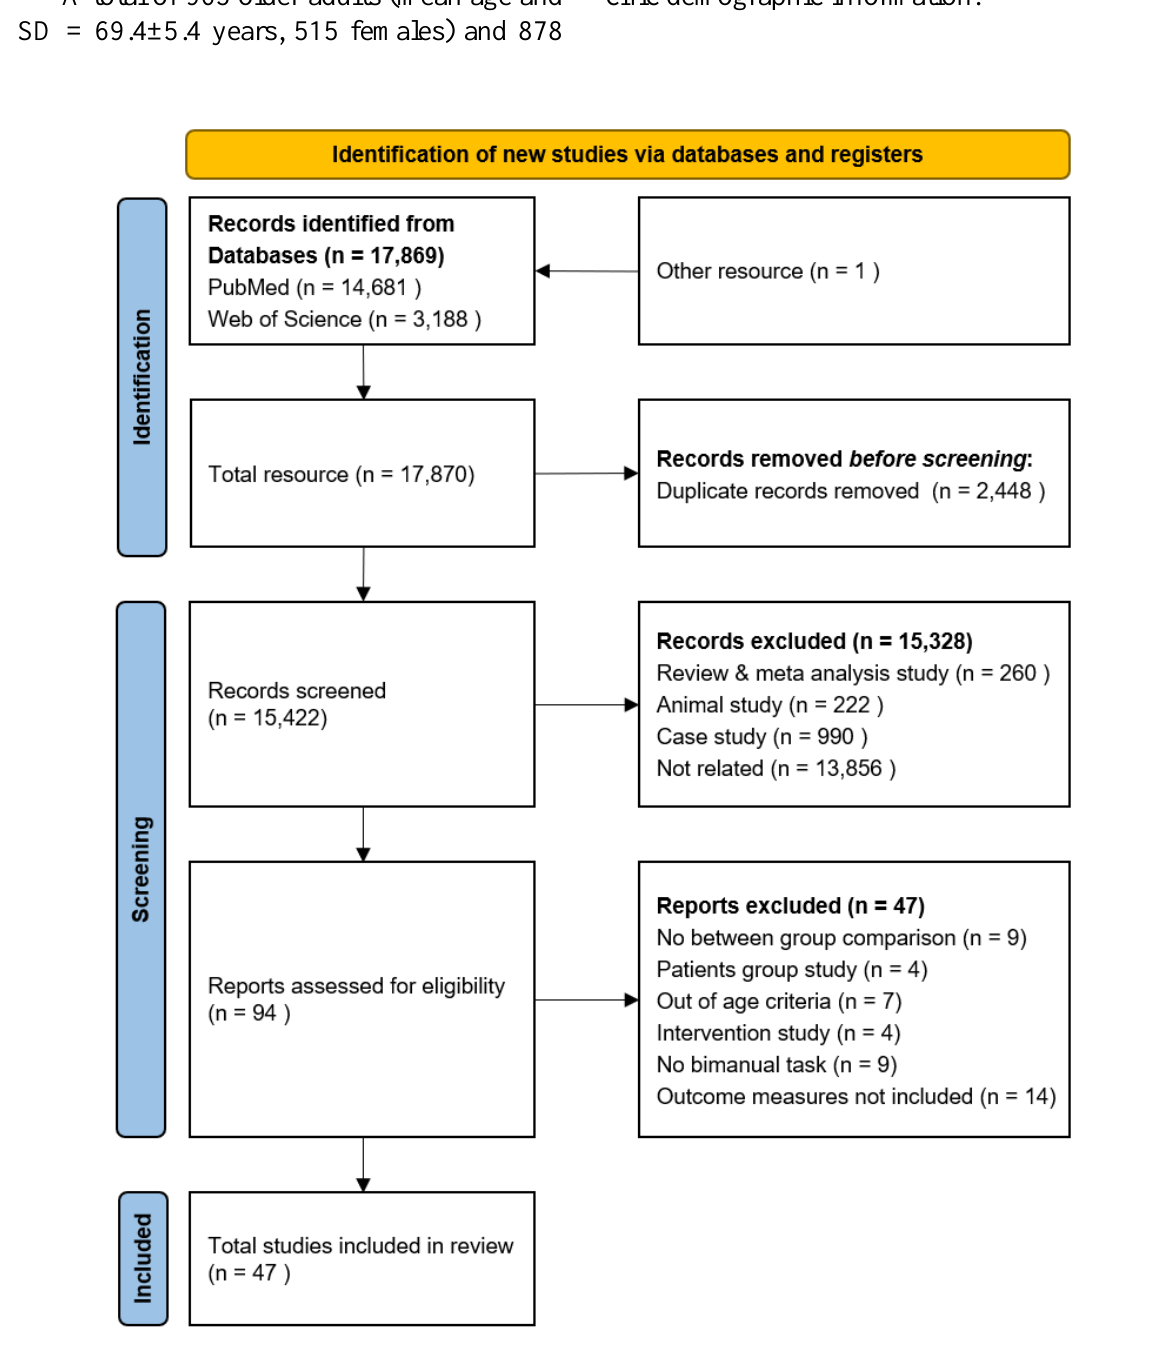
Figure 1: PRISMA flow chart describing study identification